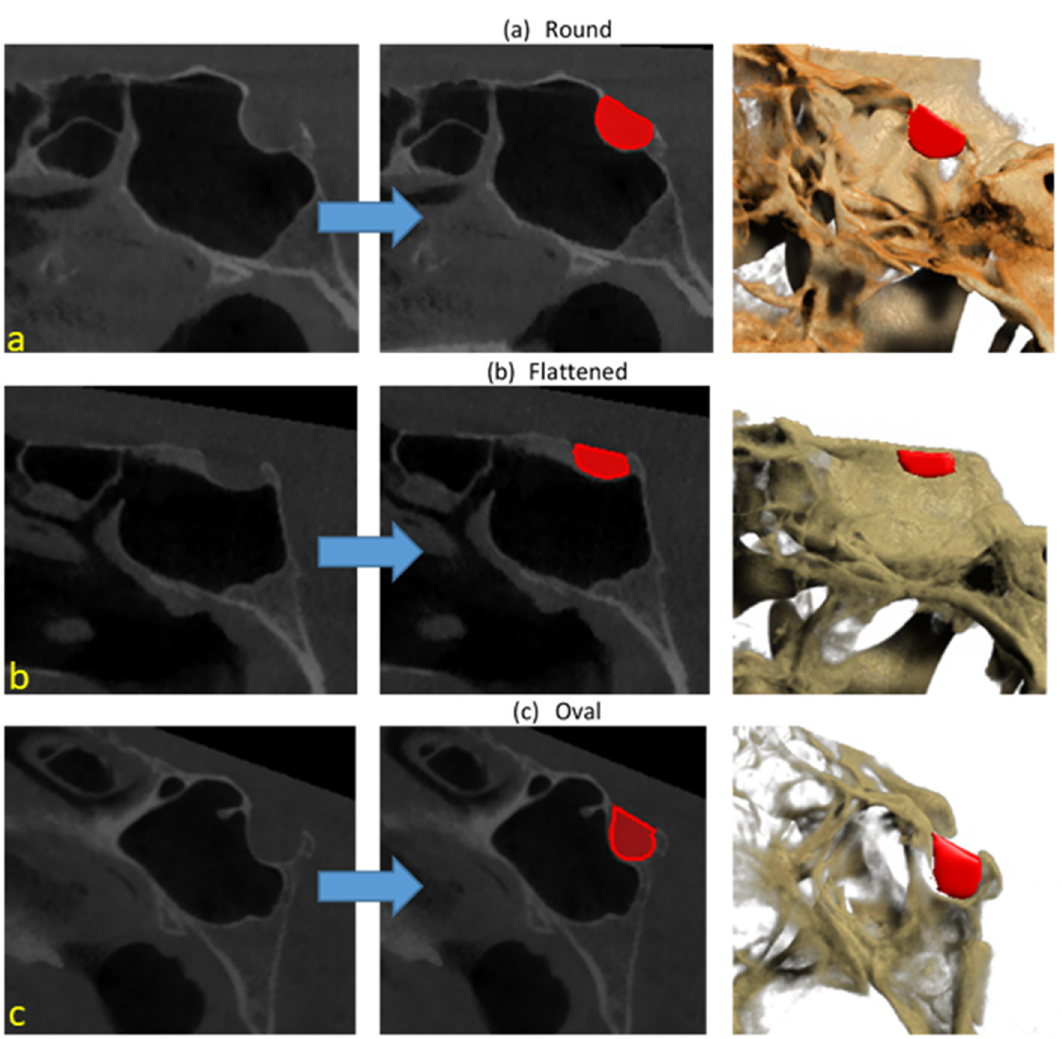
Figure 3. Automatic sella segmentation using deep-learning-based AI model: ( a ) round; ( b ) flattened; ( c ) oval.